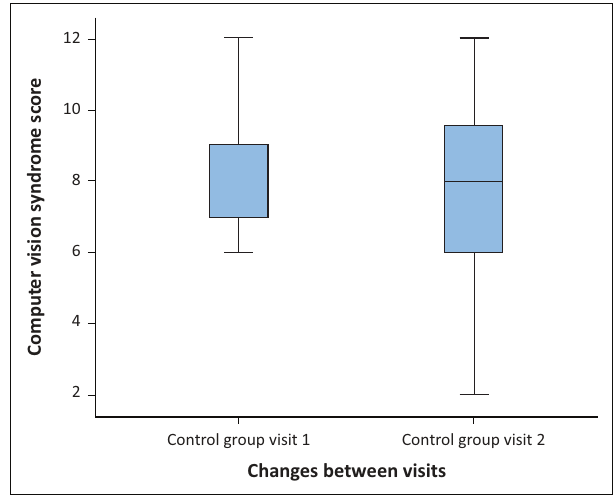
FIGURE 2: Box plots for Computer Vision Syndrome questionnaire score for the control group. No significant changes between